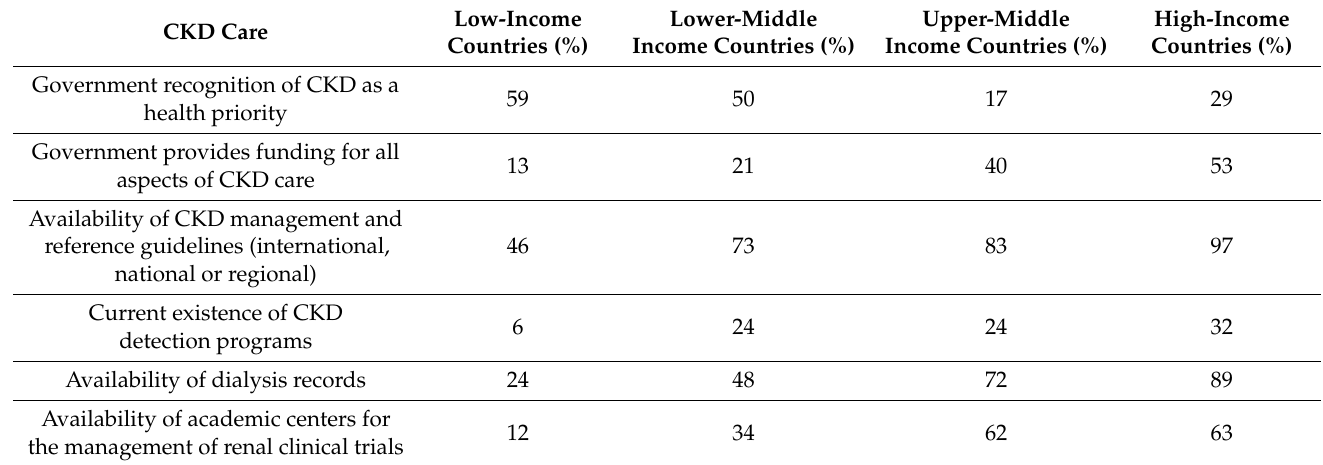
Table 1. Chronic kidney disease gaps by World Bank country